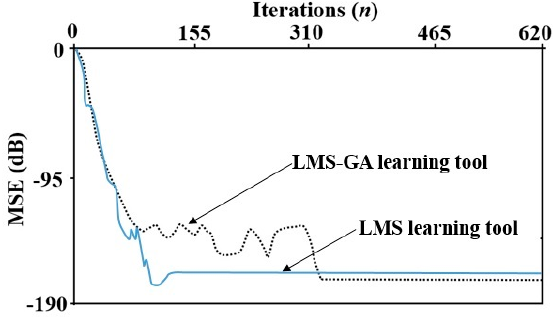
Figure 18. The learning curve of the FIR adaptive filter with integrated LMS-GA. Table 4. Simulation results of both standard LMS and LMS-GA algorithms for the FIR filter. Standard LMS Algorithm with Optimum µ LMS-GA with Optimum µ